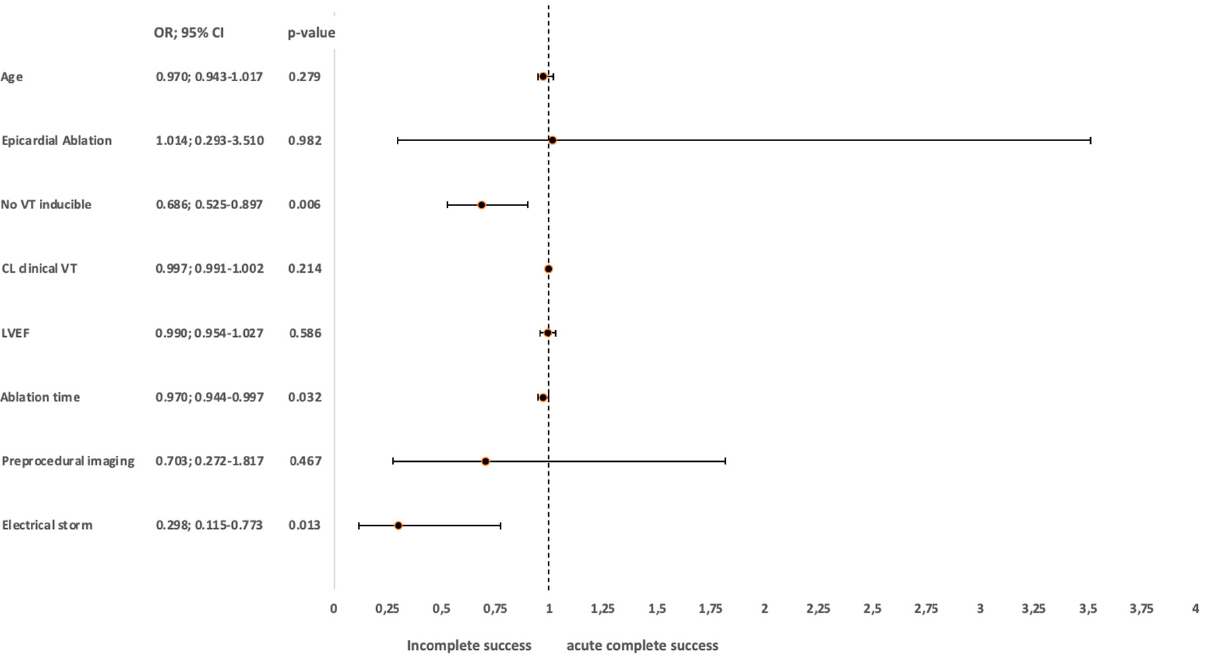
Figure 1. Multivariate logistic regression for the predictors of complete short-term success after catheter ablation of VT in ES and non-ES patients. CL, cycle length; LVEF, left ventricular ejection fraction; No. VT, number of VTs induced during the ablation; and VT CL, VT cycle length in milliseconds.